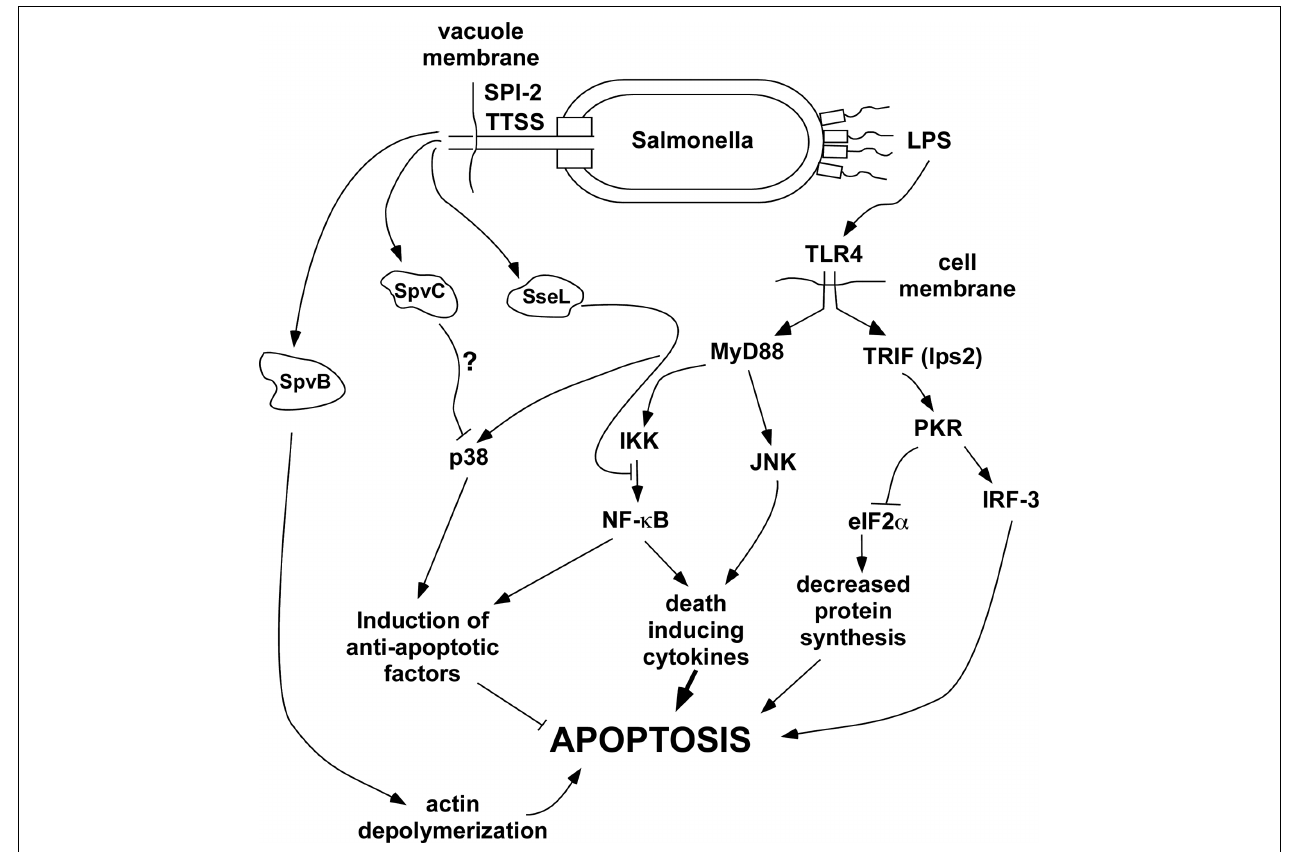
FIGURE 2 | General scheme of pathways affecting delayed apoptosis in Salmonella -infected host cells. Roles for each of the host factors were demonstrated using knockout mice or inhibitors. SpvB is known to be required and presumably acts through actin depolymerization, but the exact